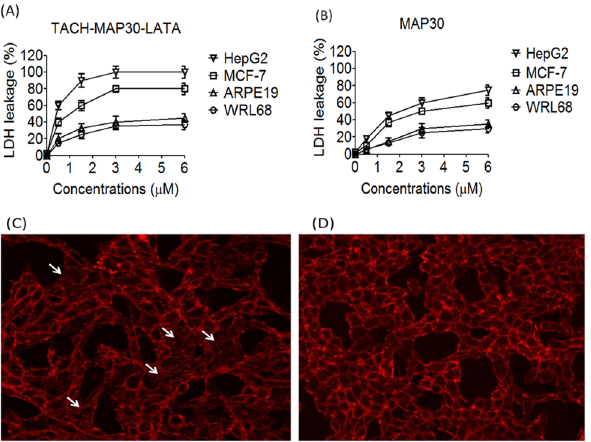
normal cell lines (approximately 40%) at 3 μ M. B) MAP30-treated cancer cells showed less than 75% of LDH leakage at 6 μ M, while the normal cells showed less than 35% C) Treatment of HepG2 cells with the peptide- fusion protein, the cells showed apparent plasma membrane damage and the cellular shape was irregular with disappeared borders (arrows) compared with untreated cells (D) Untreated HepG2 cells (Two Way ANOVA, P <